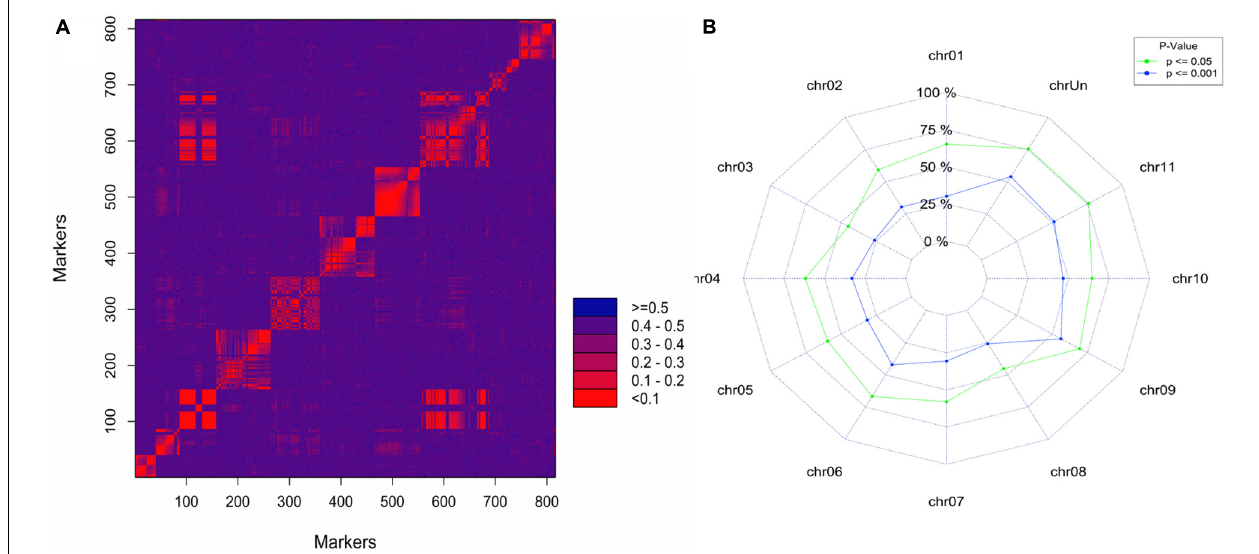
FIGURE 4 | (A) Heatmap of the 2-point recombination frequency of the AAAA × RA simplex markers segregating in the “Monyet” × “Kokopo” progeny using the marker order of “DH Pahang” reference physical map. (B) Proportion of the simplex markers showing segregation distortion based on chi-square tests for goodness of fit at the significance level of 0.05 and